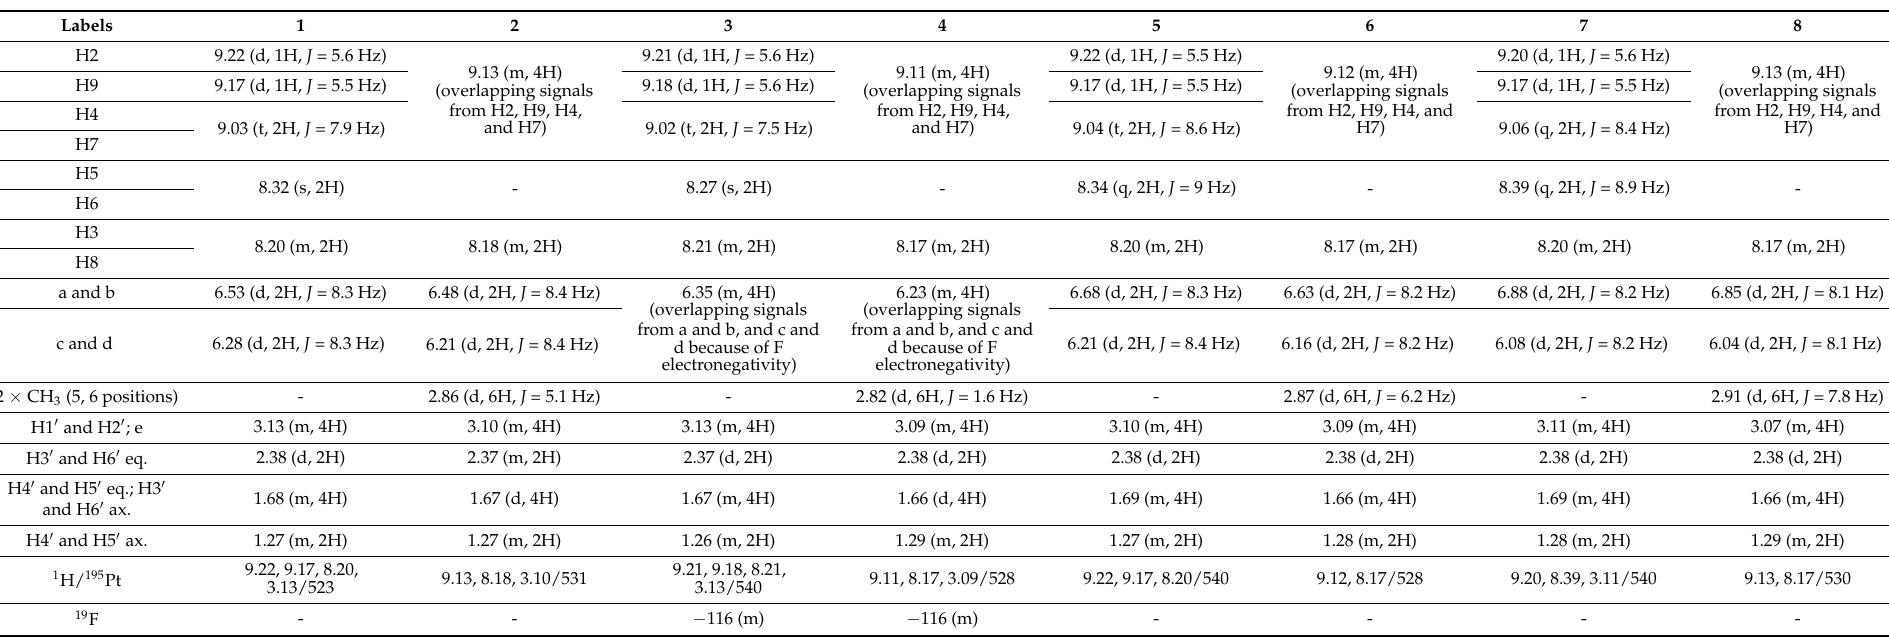
Table 2. Summary of the 1 H-NMR, 1 H- 195 Pt-HMQC, and 19 F-NMR data of 1 – 8 including chemical shifts ( δ ppm), multiplicity, integration, and J -coupling constants (Hz). Since D 2 O was used in the experiments, no amine resonances were observed due to proton